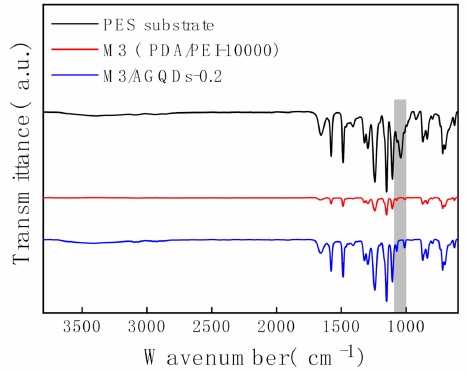
Figure 5. ATR—FTIR spectra of NF